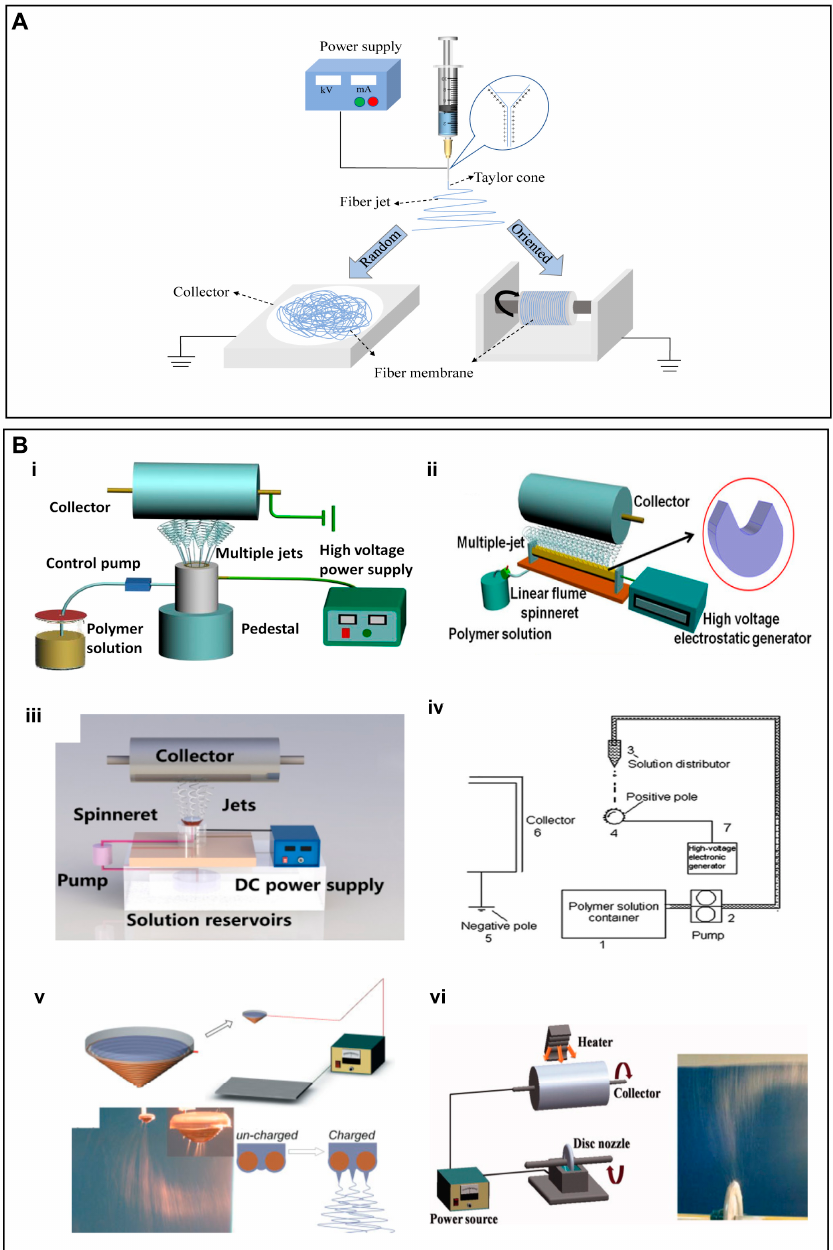
Figure 1. ( A ) Schematic illustration of an electrospinning setup for the fabrication of random and aligned nanofibers. For random nanofibers, a flat collector is used, while for aligned nanofibers, a fast rotating collector is used. ( B ) (i–vi) Schematic diagram of a few needleless electrostatic spinning devices. (i) The experimental setup of wire loop spinneret, (ii) a multi-jet needleless electrostatic spinning device with the shape of the spinneret in the upper right corner, (iii) mushroom-electrospinning setup, (iv) splashing needleless electrospinning system, (v) wire coil electrospinning setup, (vi) apparatus for disc electrospinning and a photo of the electrospinning process. ( B ) (i) Reproduced with permission from reference [37]. Copyright 2019. Published by Elsevier Ltd. (ii) Reproduced with permission from reference [42]. Copyright 2019 Polymers. (iii) Reproduced with permission from reference [43]. Copyright 2020, the author(s). Published by Elsevier Ltd. (iv) Reproduced with permission from reference [44]. Copyright 2010, Society of Plastics Engineers. (v) Reproduced with permission from reference [45]. Copyright 2009, Society of Plastics Engineers, and (vi) Reproduced with permission from reference [46], Copyright 2012, Wiley Journals.